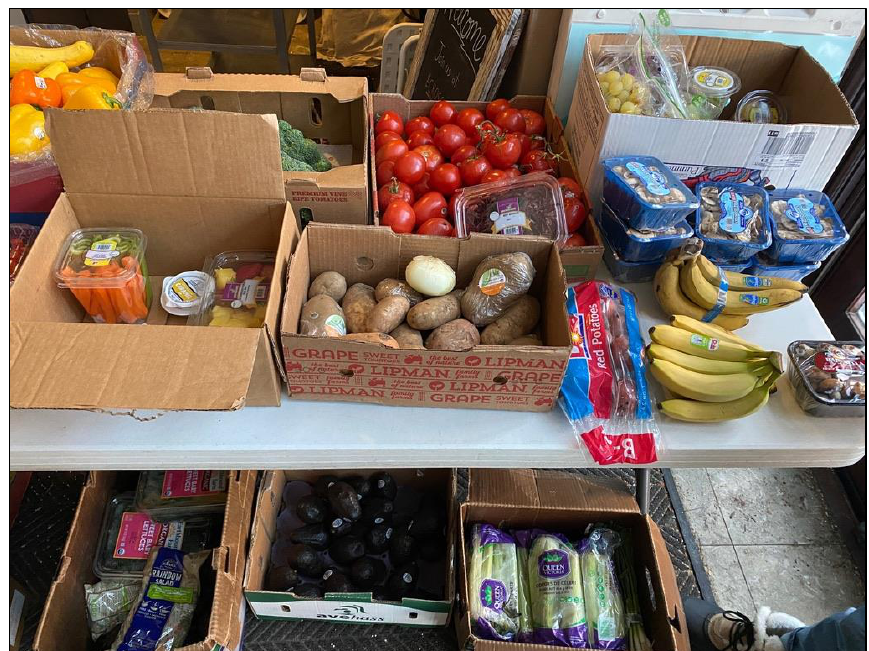
Figure 4. Socially Distanced Food Handouts Took Place at Designated Times Twice per Week During the First Stages of the COVID-19 Pandemic Photo courtesy of Campus Food